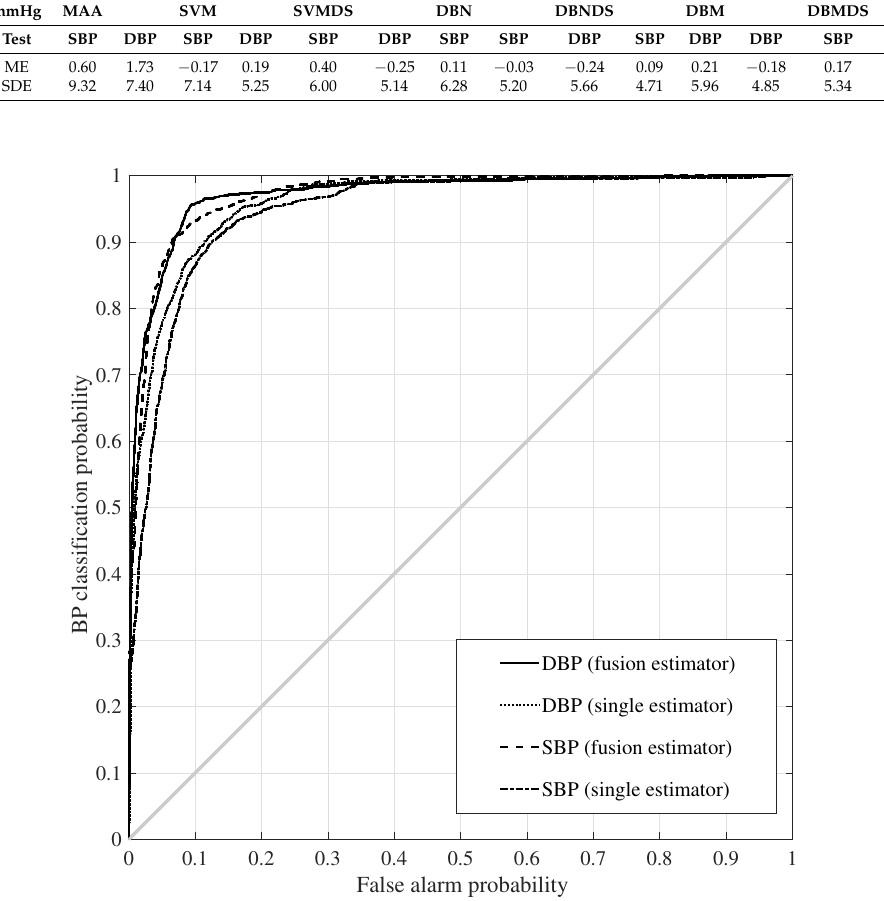
Figure 4. ROC (receiver operating characteristic) curve based on experimental conditions using the DBMDS (DBM based DS fusion) estimator vs. DBM single estimator for SBP (systolic blood pressure) and DBP (diastolic blood pressure)